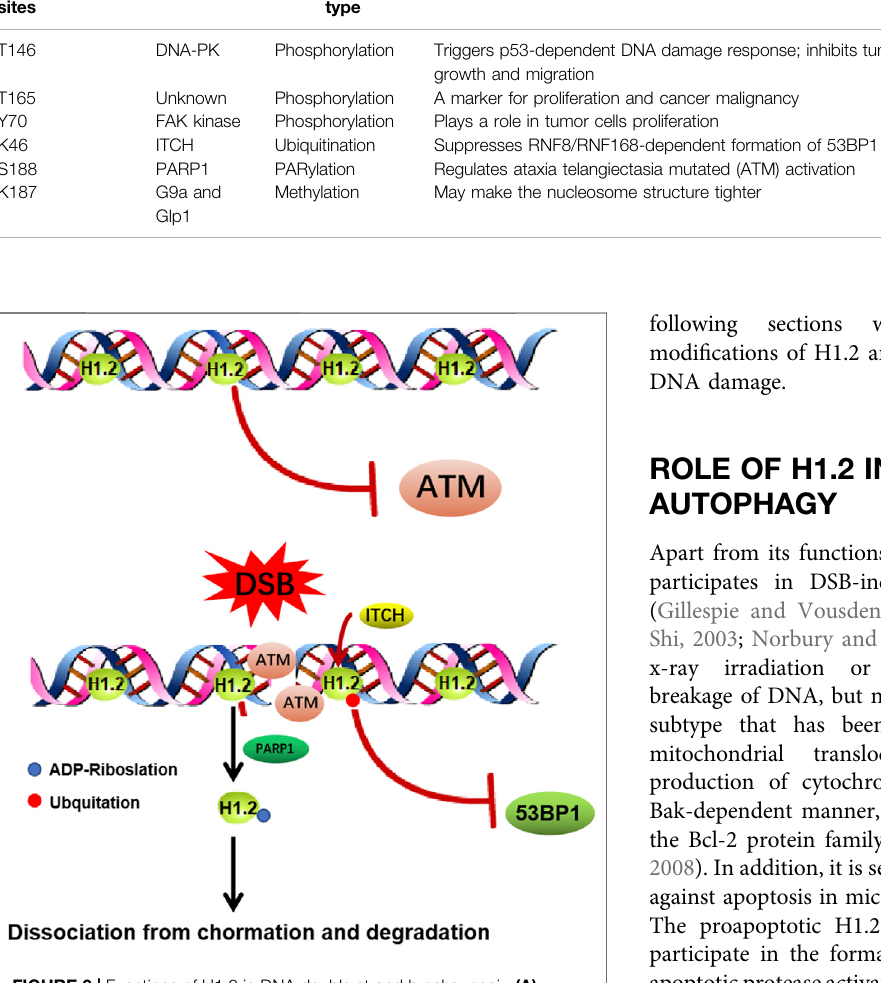
FIGURE 3 | Functions of H1.2 in DNA double strand breaks repair. (A) H1.2 protects chromatin from aberrant ATM activation through direct interaction with the ATM HEAT repeat domain and inhibition of ATM (ataxia telangiectasia mutated) recruitment. Upon DNA damage, H1.2 undergoes rapid PARP1-dependent chromatin dissociation through PARylation (Protein poly ADP-ribosylation) and further proteasomal degradation, leading to ATM recuriment to sites of DNA damage and ATM activation, facilitating DNA damage repair. (B) ITCH-mediated polyubiquitination of H1.2 K46 site suppresses RNF8/RNF168-dependent formationof53BP1fociandDSBrepair(ITCH:thespeci fi cE3ubiquitinligase).